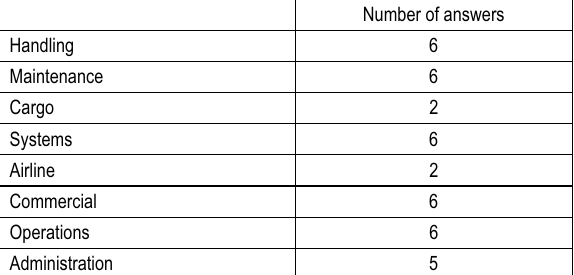
Table 6. Answer to the question: organization of the airline company